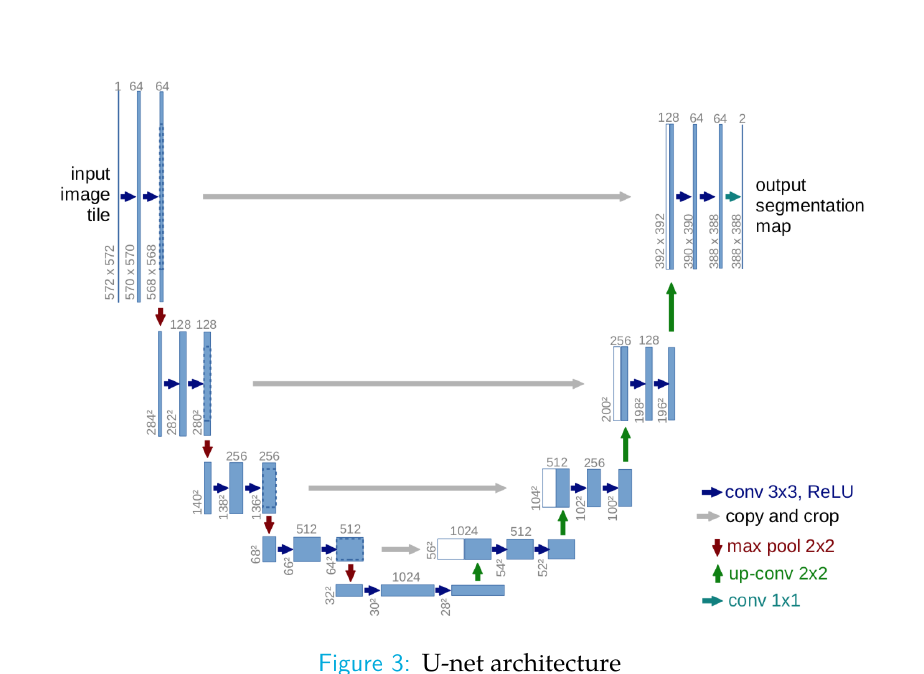
Figure 3: U-net architecture